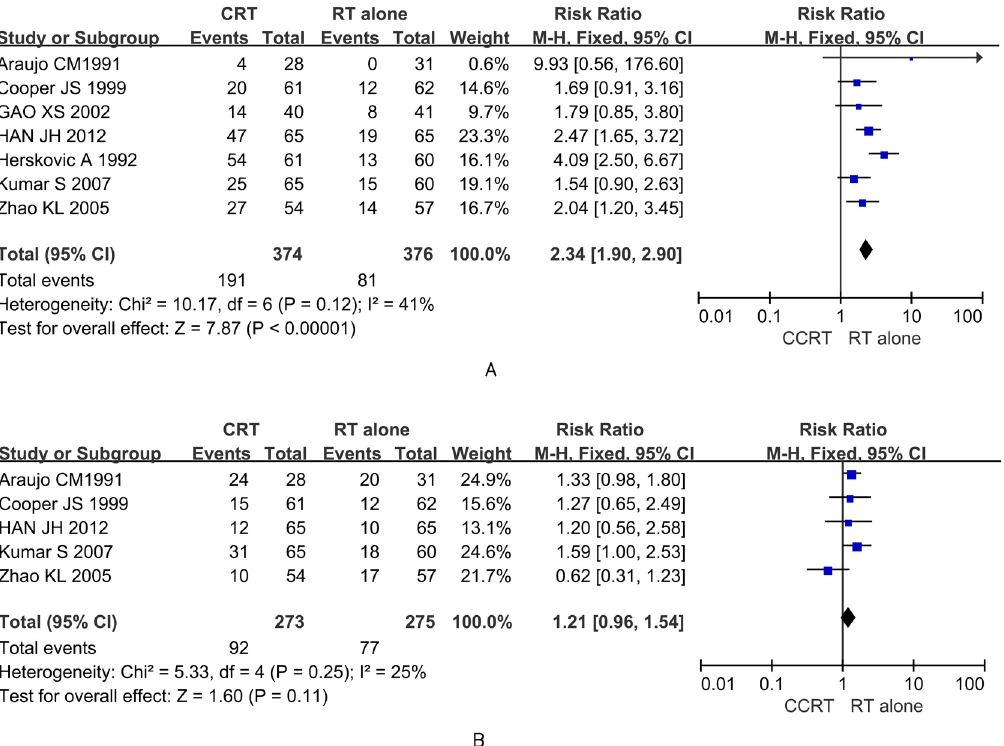
Fig 3. Forest plots comparing rates of toxic effects for the CCRT group and RT alone group. (A) Rate of acute toxic effects. (B) Rate of late toxic effects.